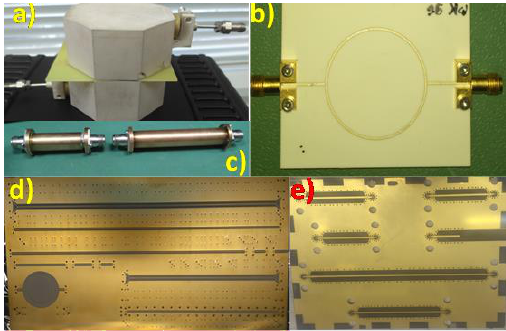
Fig. 3. Set of test fixtures for PCB material research and characterization.